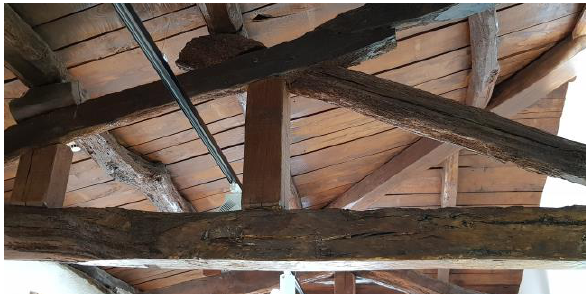
Figure 6. Detail of the wooden framework of the Álvaro Cunqueiro House Museum. Mondoñedo. Source: https://novacarta.eu.